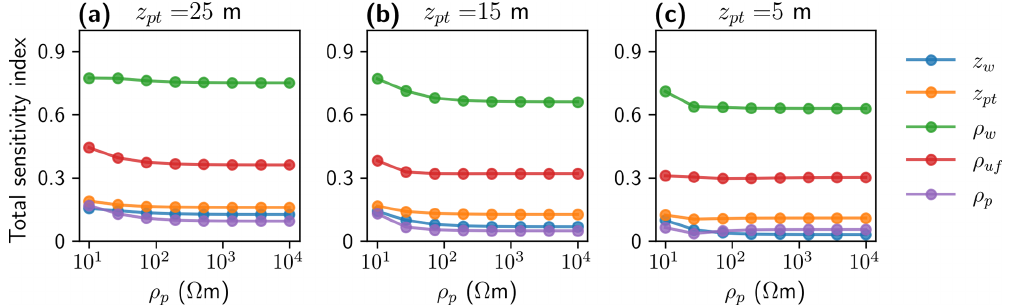
Figure 6. Global sensitivity results for the Bykovsky field site considering different 1D model scenarios with an IBPT at a depth of (a) 25m, (b) 15m, and (c)